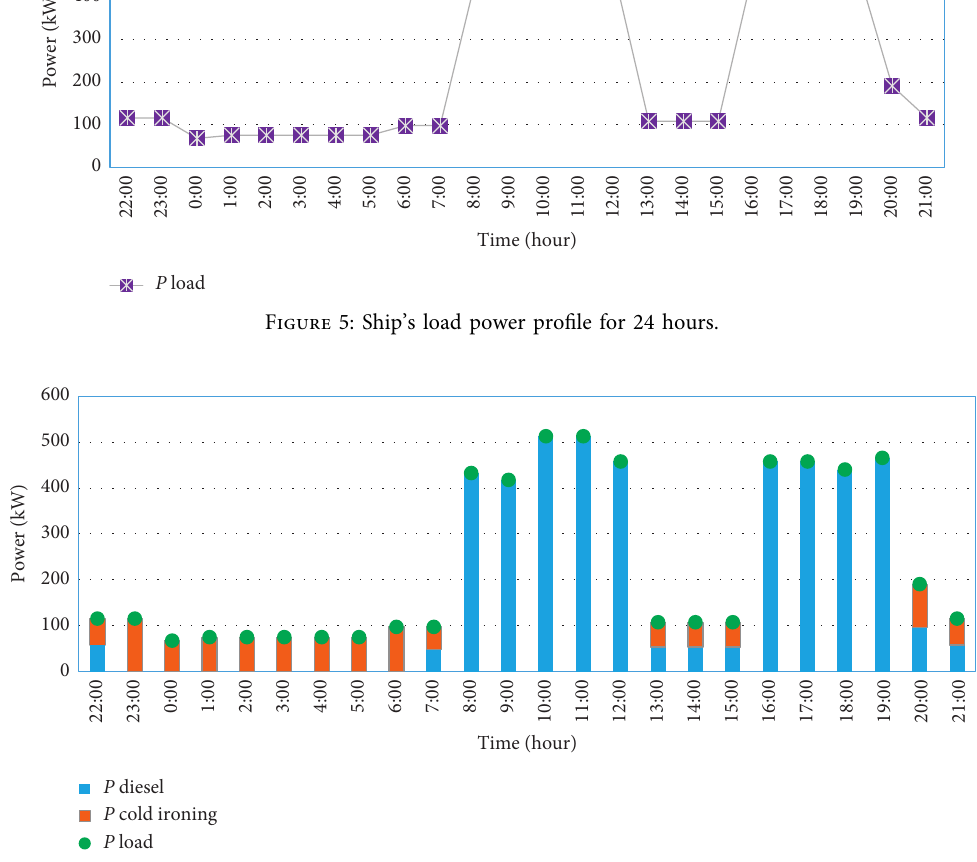
Figure 6: Hybrid energy management system case